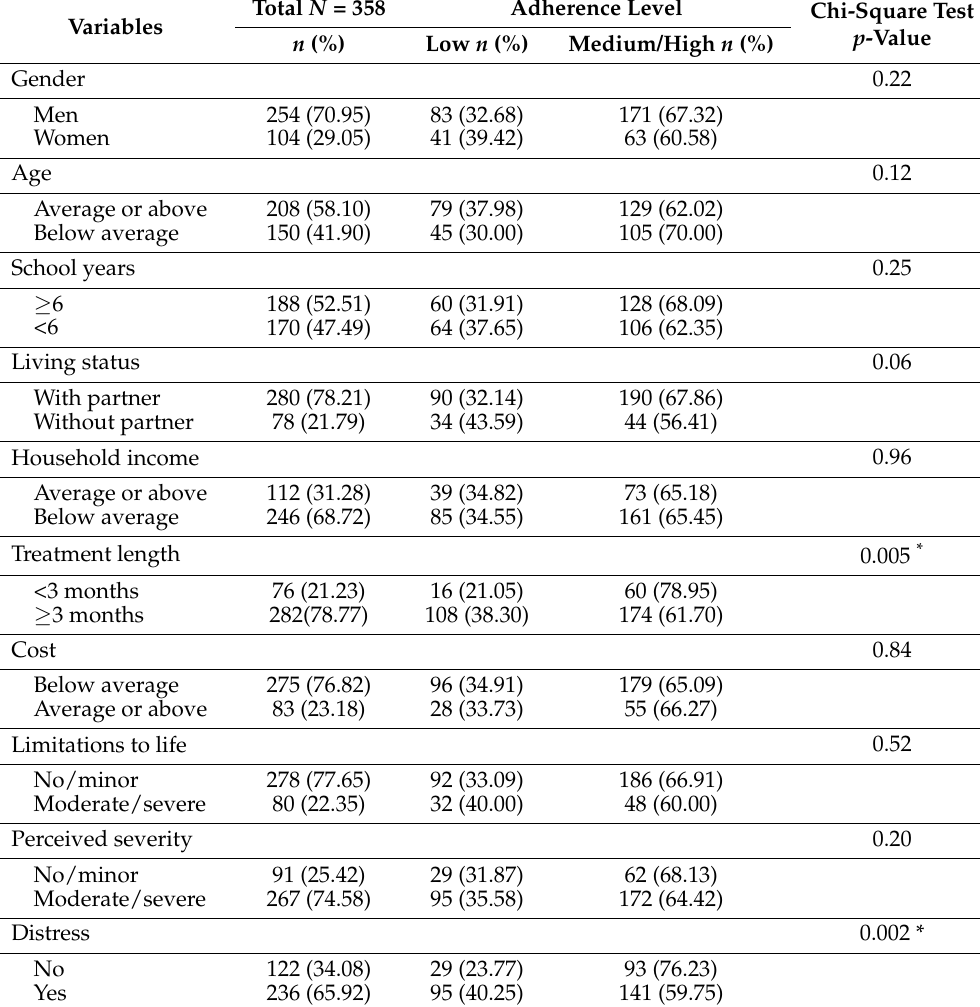
Adherence level by sociodemographic variables, disease-related variables, and psychological